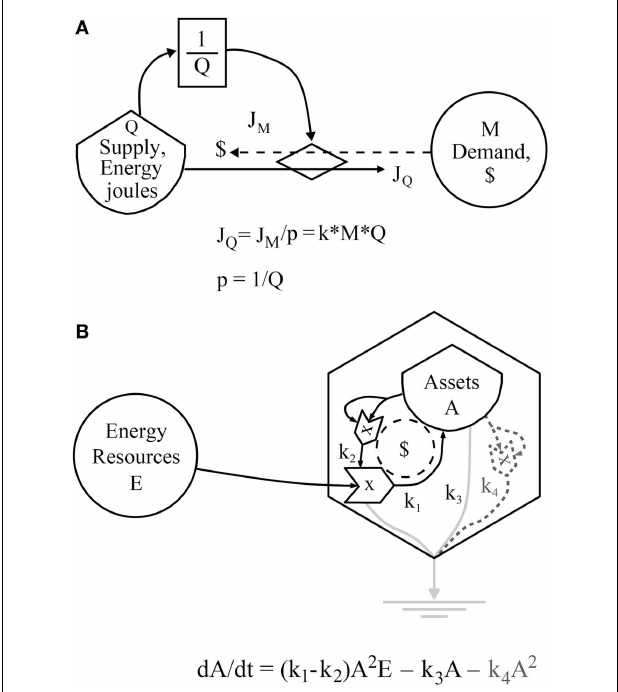
FIGURE 2 | (A) An ESL model of one possible coupling between energy and money flows. A flow of money, J M , ($/y) directed toward the purchase of available energy Q (Joules) is demand. In this case, the price is inversely proportional to the supply of available energy (1/Q), so as the supply decreases the price is adjusted upward.The flow of energy, J Q , (J/y) is then proportional to the demand divided by the price. (B) A model of the super-accelerated growth of system assets, A, due to cooperative interactions (A 2 term on pathway k 2 ) among people and their institutions. Symbols drawn with dotted dark gray lines and the dark gray term in the equation indicate that a quadratic drain is needed to level growth.The dashed circle indicates the dollar flows coupled to the flow of available energy and light gray lines are used energy leaving the system.The third power law comes into play due to the A 2 E (E 3 )